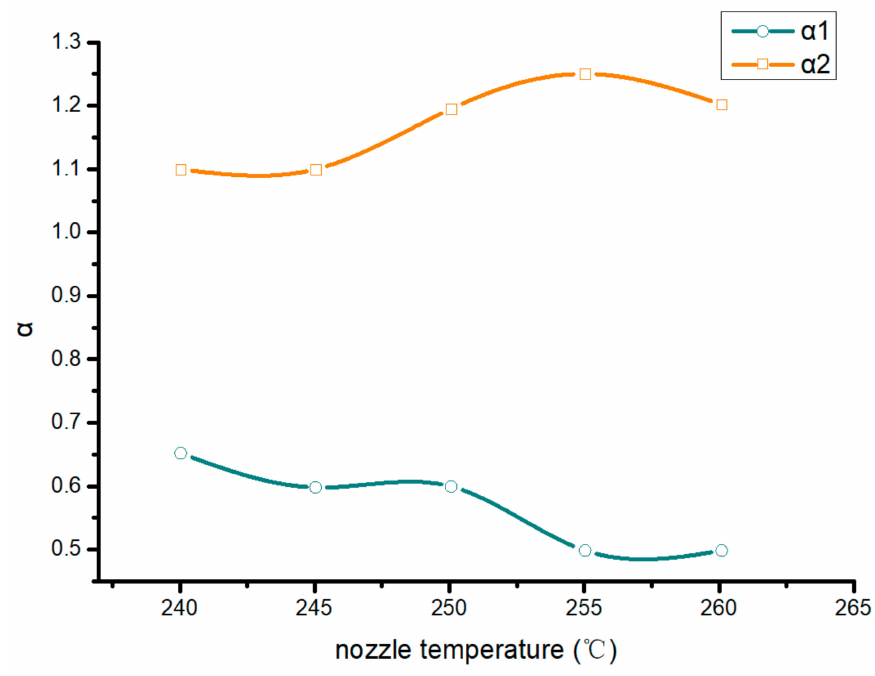
Figure 7. The ratios of extrusion velocity to filling velocity at di ff erent temperatures.